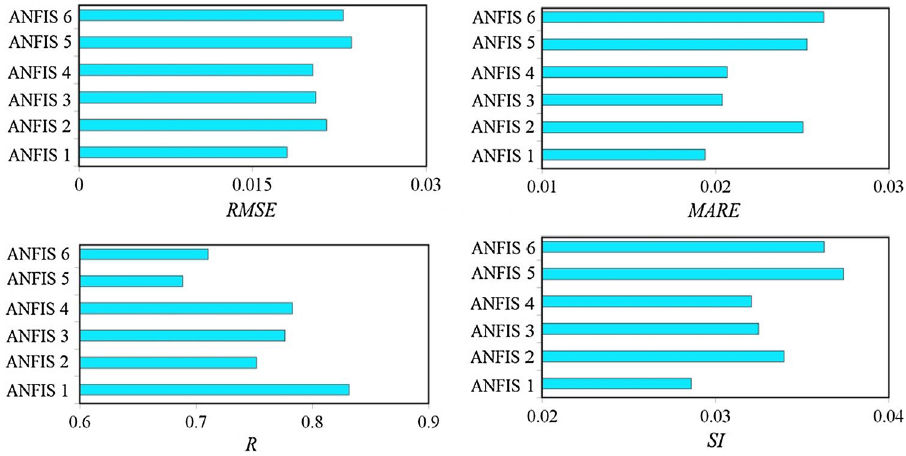
Fig. 9 Comparison of different statistical indices for six ANFIS